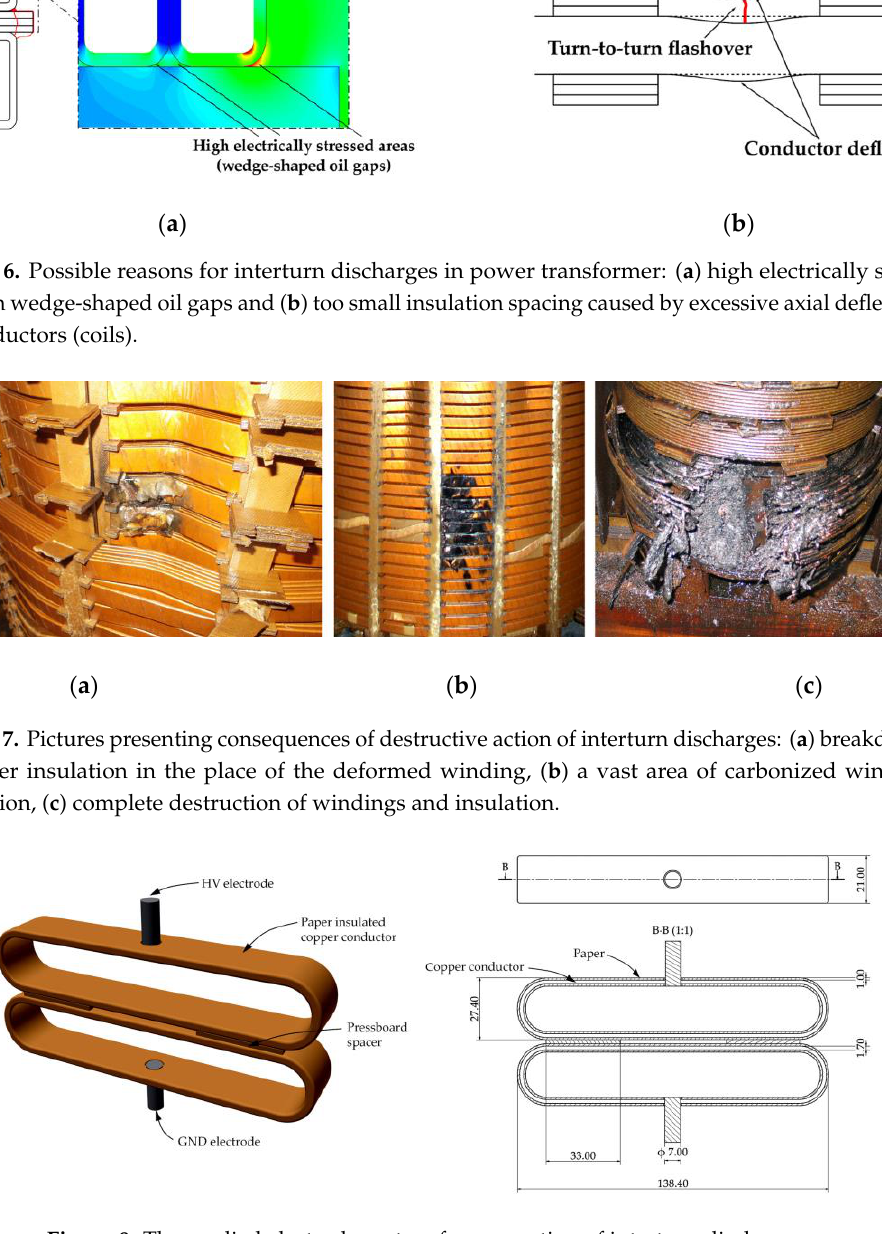
Figure 8. The applied electrode system for generation of interturn discharges.